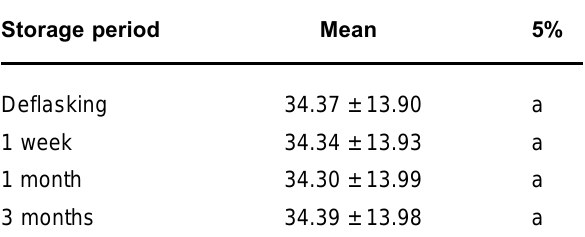
TABLE 1 - Means ± SD of teeth movement (mm) for the deflasking and water storage periods, regardless of the teeth distances